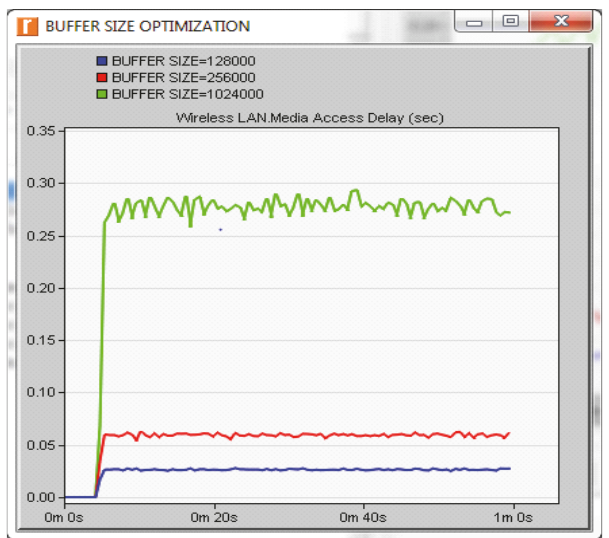
Figure 27: WLAN buffer size optimization for lower media access delay.